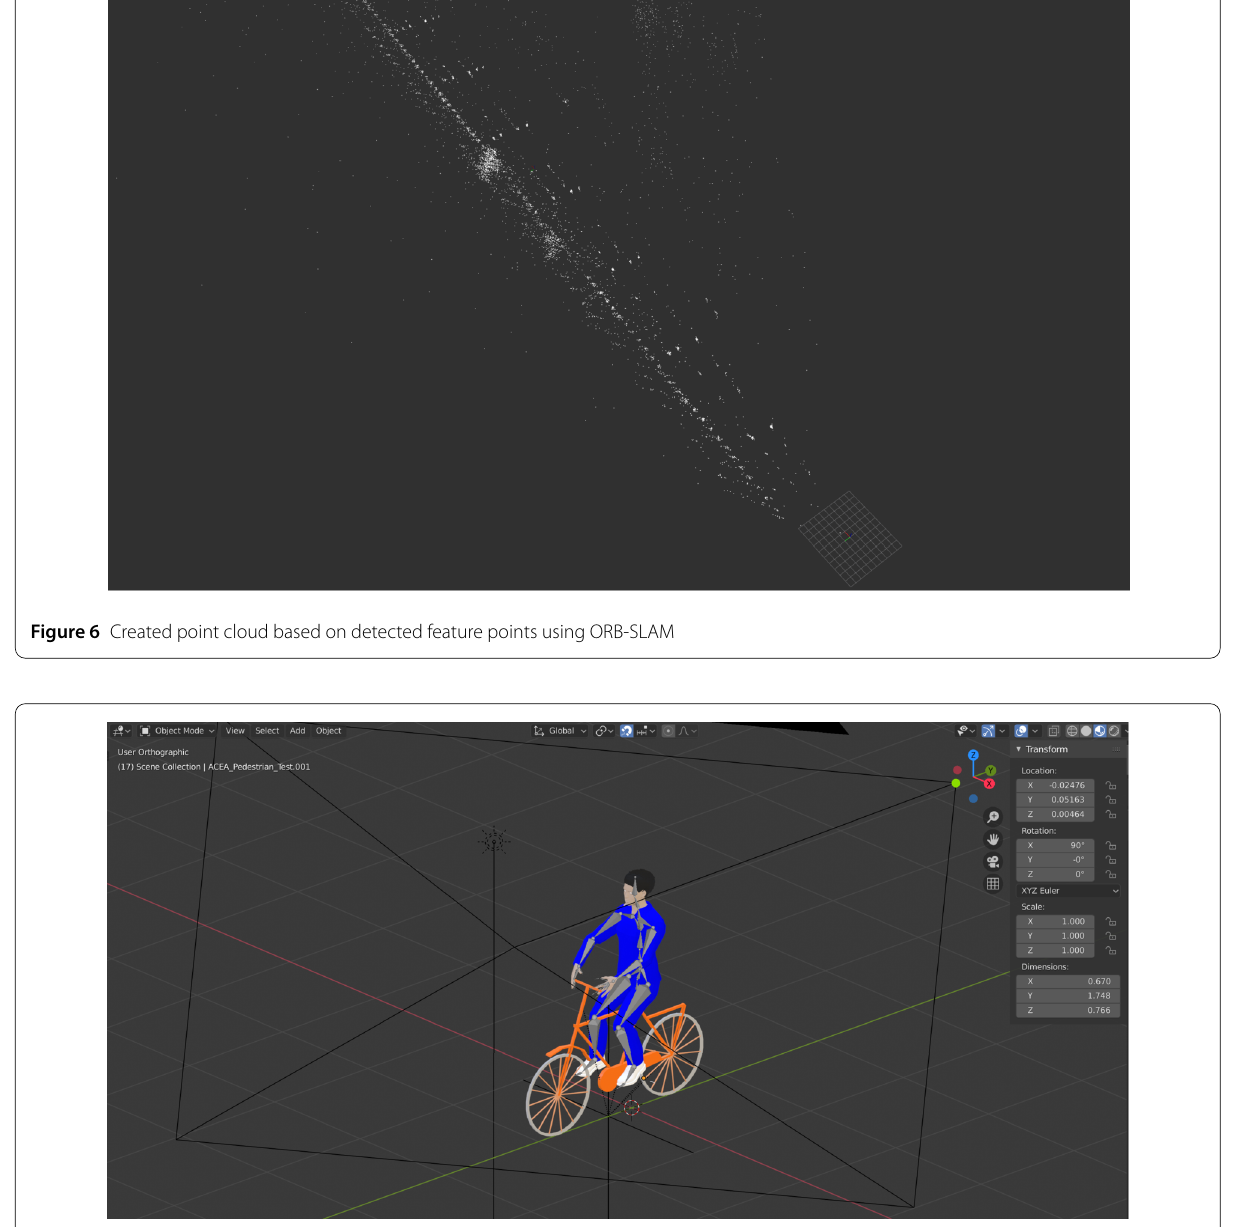
ure 8 shows the augmentation of the scene by the virtual cyclist. It can also be seen from the grid displayed on the floor that the cyclist is on the recognised plane. The last step in our AR-ADAS pipeline is to drive through the test scene again with the physical vehicle.